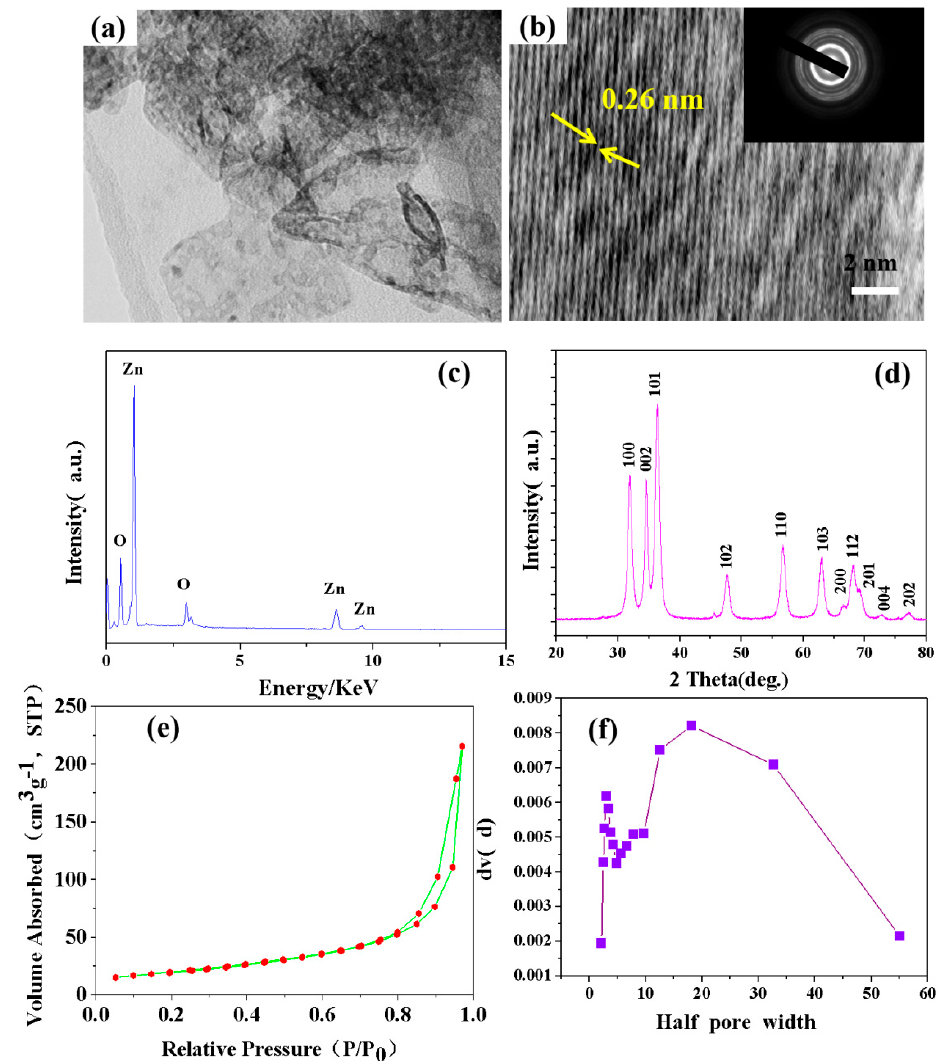
Figure 3. ( a ) Low-magnification TEM images of the porous ZnO nanosheets. ( b ) High-resolution TEM images of the porous ZnO nanosheets. ( c ) Energy spectrum analysis of the porous ZnO nanosheets. ( d ) XRD patterns of the porous ZnO nanosheets. ( e ) Nitrogen adsorption/desorption curve of the porous ZnO nanosheets. ( f ) Pore size distribution curve of the porous ZnO nanosheets.